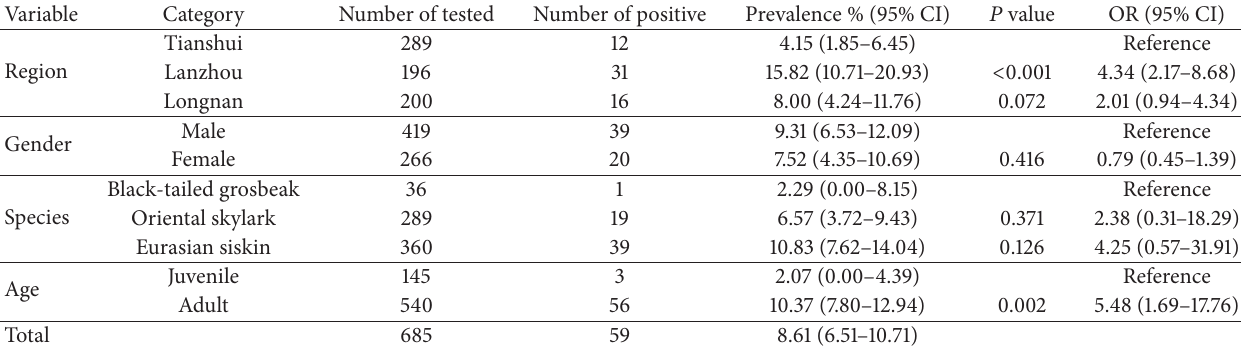
Table 2: Analysis of the variables associated with HEV seroprevalence in pet birds in northwest China. Variable